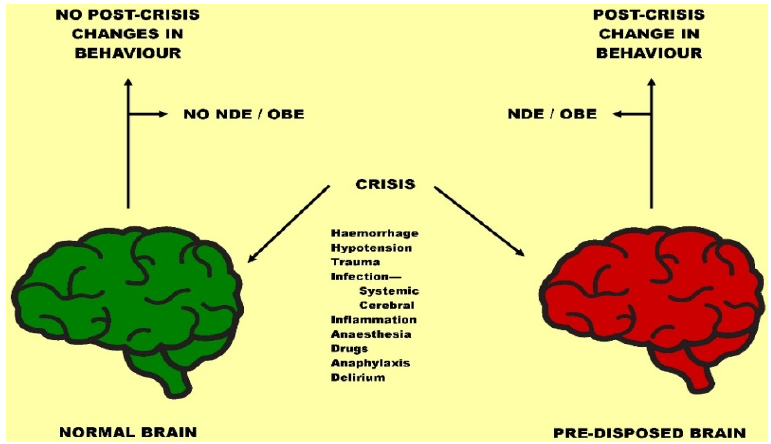
Figure 2. It is widely assumed that undergoing medical or psychological crises is the direct cause of ND/OBE and out of which changes in post-event behaviour arise. But an increasing number of neurological papers suggests that a variety of behavioural aberrations occur because the brain is already predisposed by an earlier insult not routinely clinically observable or apparent. Then, subsequent to these varied later crises, marked changes in post-experiential behaviour then may appear. Genetic factors are also likely to be operative here as well. It is therefore possible that a changed behavioural phenotype is the principal outcome of subjects following one of the typical clinical crises undergone (listed), so that the ND/OBE, itself, might be viewed only as an